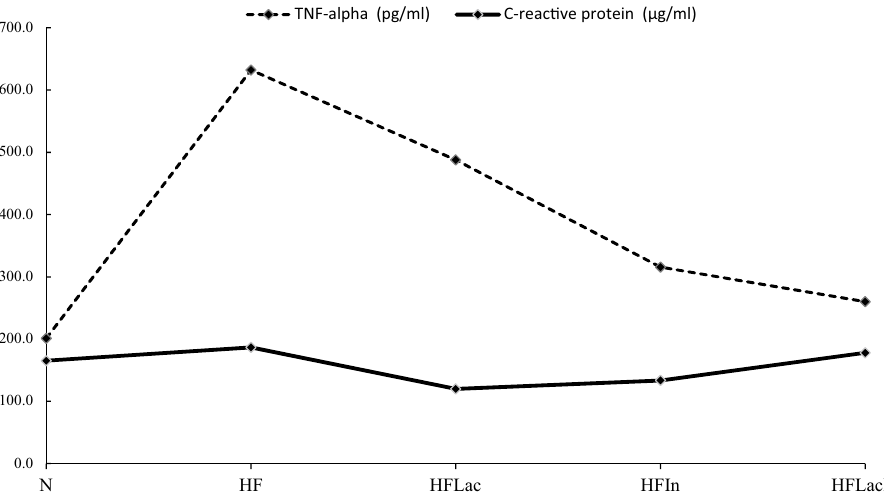
Figure 4. Serum concentrations of tumor necrosis factor-alpha (TNF-alpha; pg/ml) and C-reactive protein (CRP; µg/ml) of the rats in each group (n = 13). (N) Rat fed a normal diet (HF) Rats fed with a high fat diet (HFLac, HFIn, HFLacIn). Rats fed with a high fat diet and L. acidophilus , inulin, and L. acidophilus + inulin, respectively.